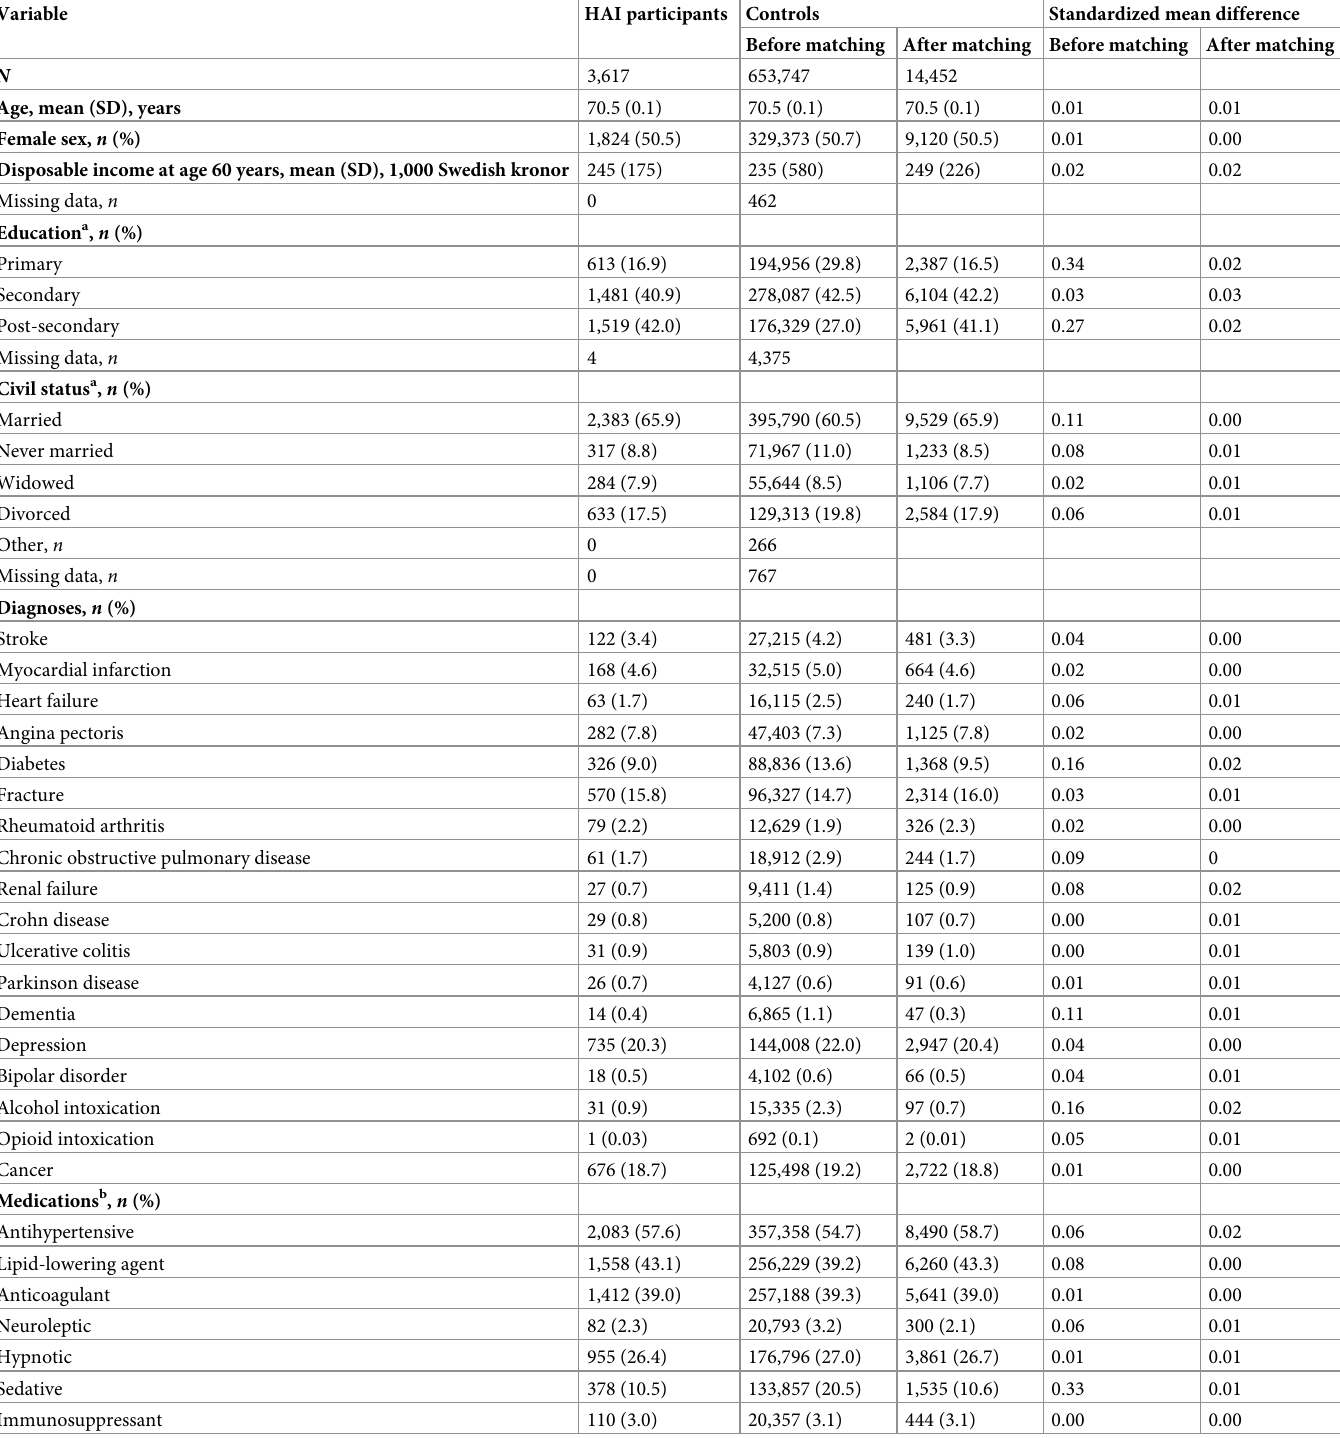
Table 1. Baseline characteristics of Healthy Ageing Initiative (HAI) participants and the control population before and after